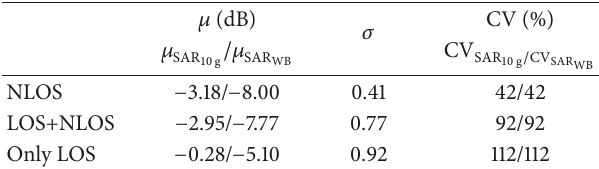
Table 3: Characteristic of the distribution of exposure values at 900 MHz.